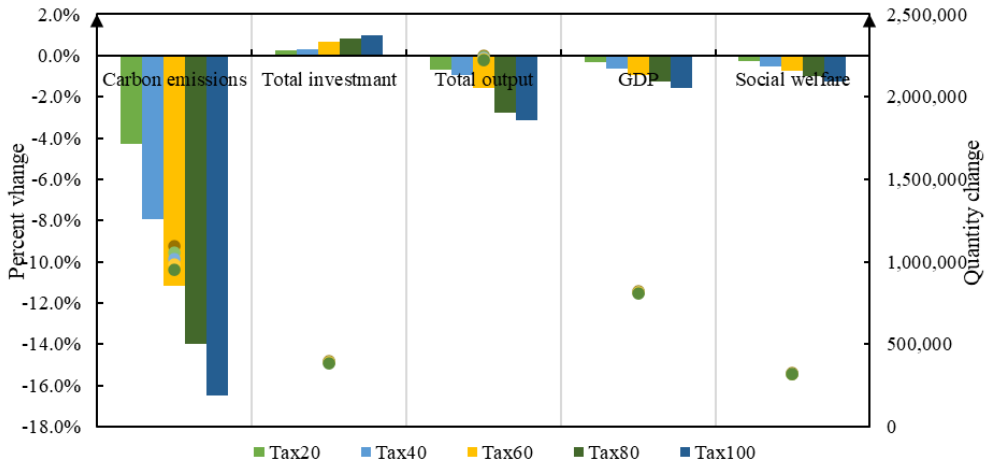
Figure 4. Impact on macroeconomy indicators.